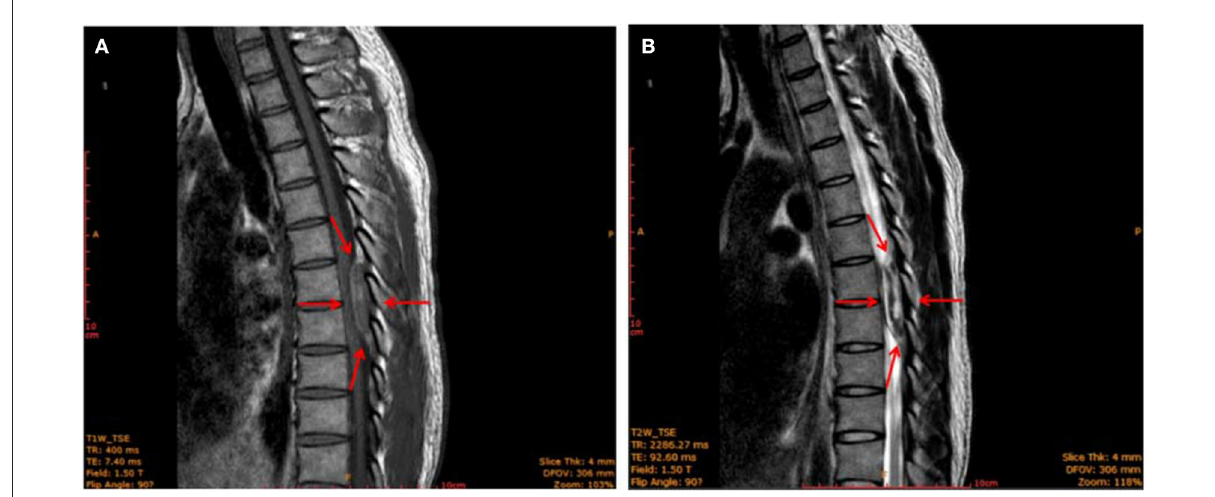
FIGURE1 MRI image of the thoracic spine (sagittal plane) showing an epidural mass (red arrows) with a clear border measuring 11 × 16 × 11mm located at the level of 2 thoracic vertebrae (T7–T8). The mass was iso-intense on T1-weighted images (A) and showed mixed-signal intensity on T2-weighted images (B)